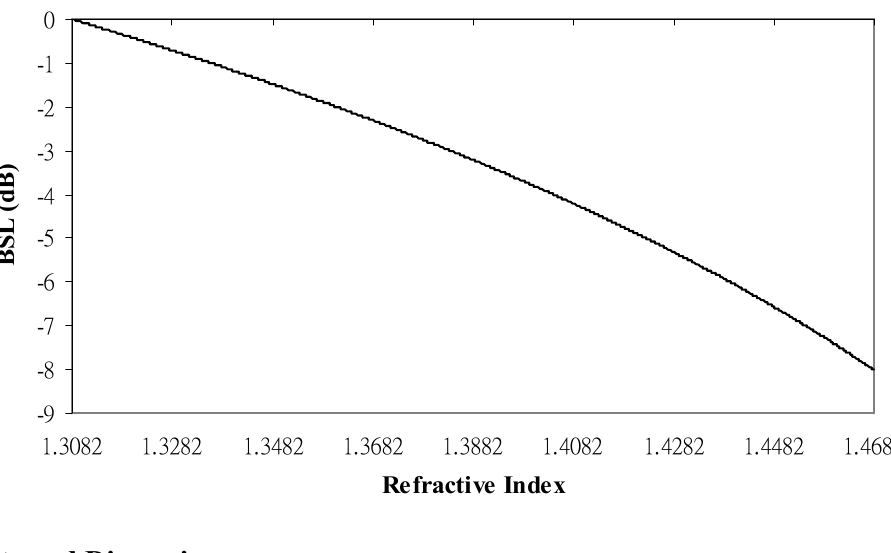
Figure 1. Simulation for the normalized OTDR measured power level versus material